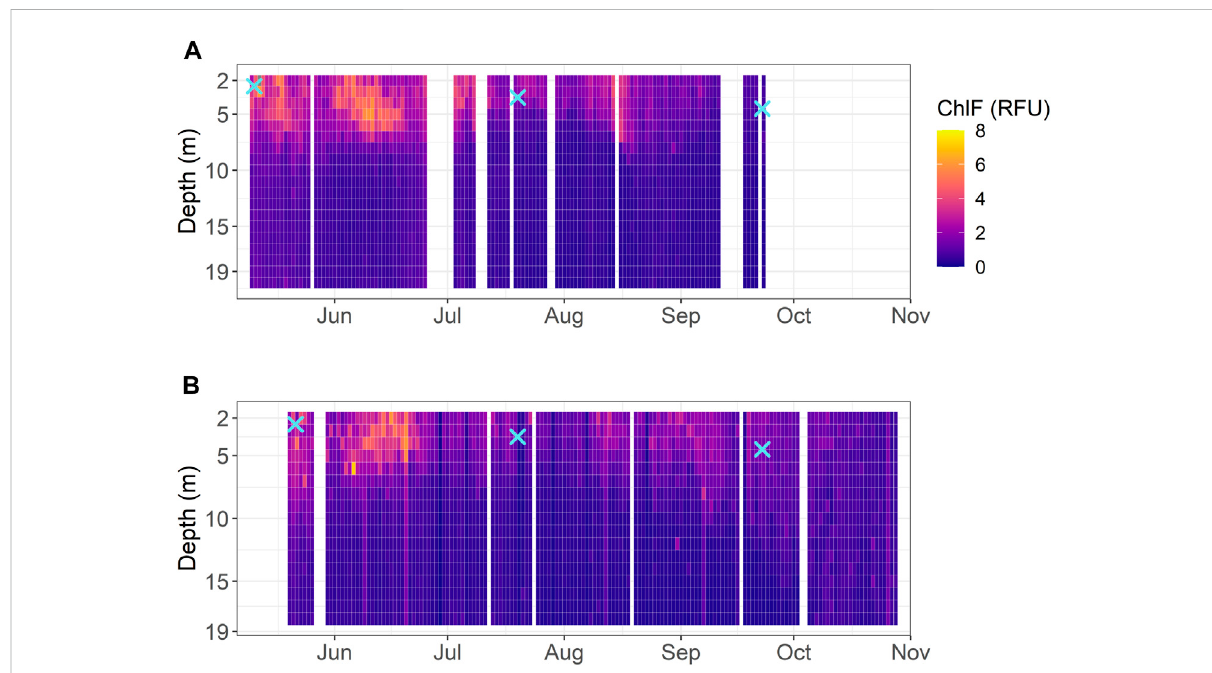
FIGURE 7 NPQ corrected ChlF midday pro fi le in Saadjärv in 2018 (A) and in 2019 (B) . Crosses denote Z 90 (derived from in situ Secchi